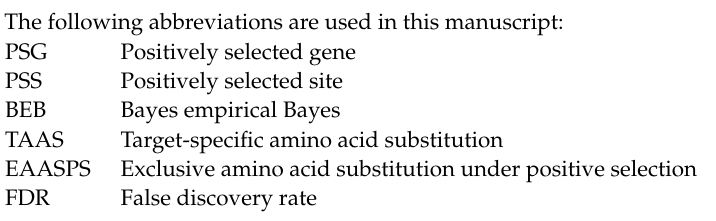
Table S3: List of tetrapod-and-mudskipper model PSGs, Table S4: Exclusive amino acid substitutions under positive selection (EAASPS, TAAS + Branch-site model of CodeML), Table S5: ClueGO results of mudskipper-specific PSGs, Table S6: ClueGO results of tetrapod-specific PSGs, Table S7: Rapidly contracted gene families in both tetrapod and mudskipper lineages, Table S8: Number of genes in the Ensembl protein families defined as a single gene family by CAFE, Table S9: Genomic coordinates of crystallin gene synteny analysis, Table S10: List of aquatic fish specific orthologues absent in tetrapods and mudskipper. Figure S1: Concept of target-specific amino acids substitution (TAAS) analysis. Figure S2: Detection of EAASPS (mudskipper model), Figure S3: Detection of EAASPS (tetrapod model), Figure S4: Detection of EAASPS (tetrapod-and-mudskipper model), Figure S5: Protein-protein network of PSGs involving in both “DNA repair” and “response to